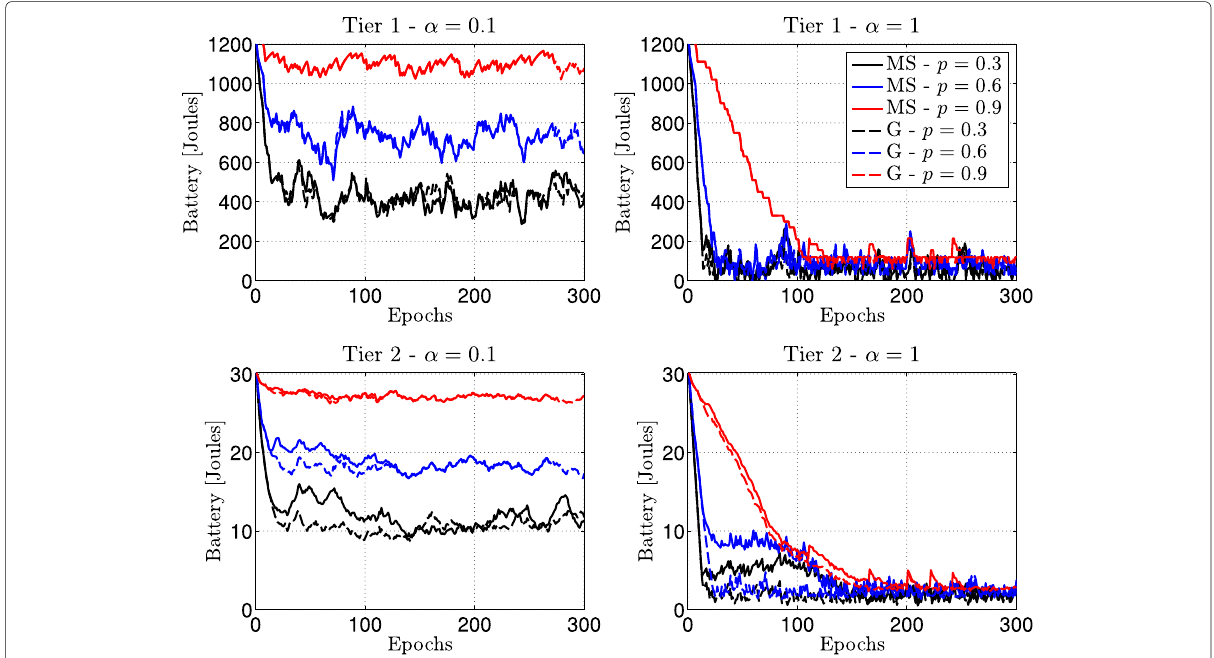
Fig. 6 Average battery evolution (among BSs) of tier 1 and tier